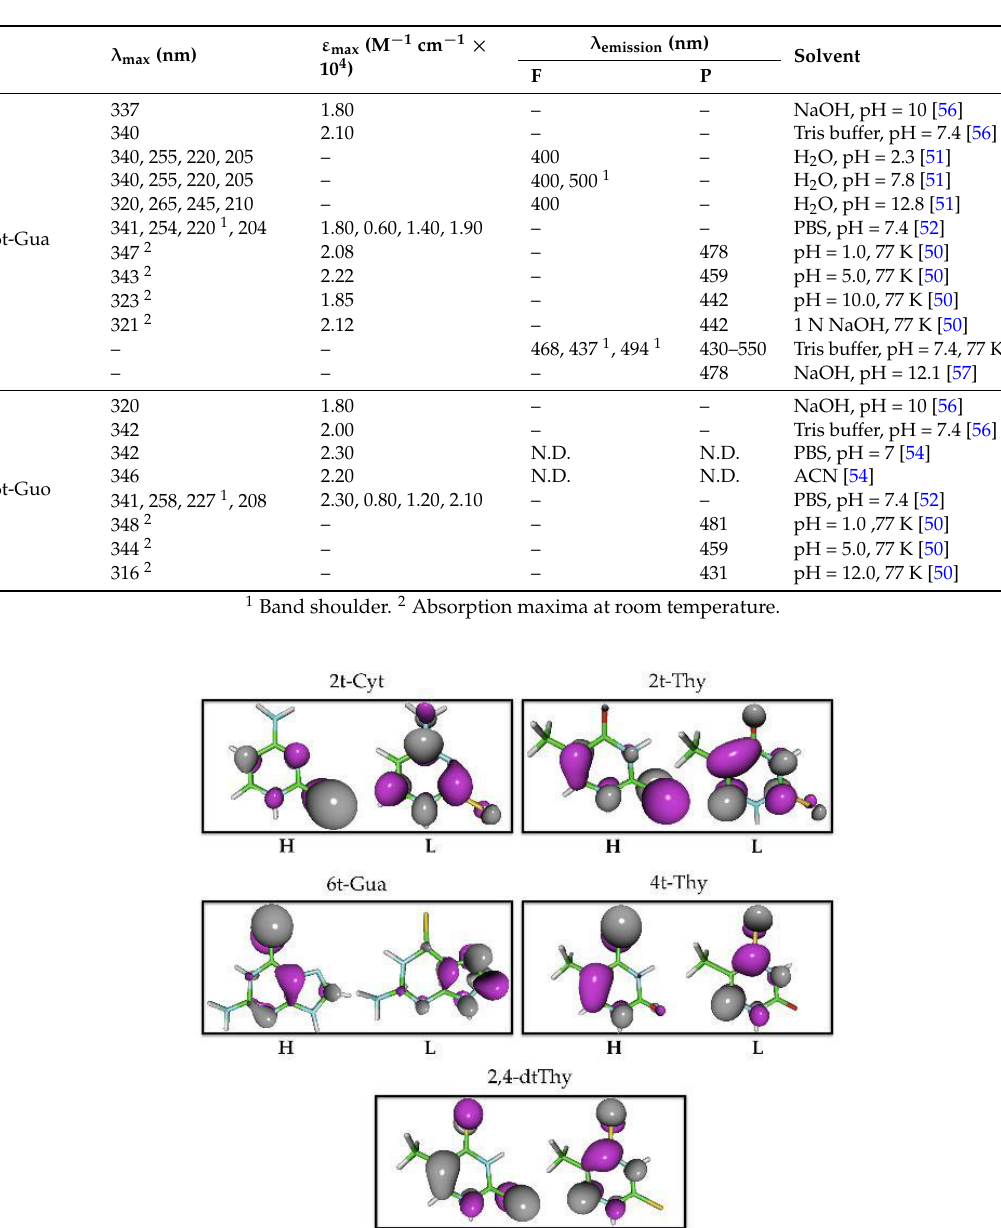
Table 1. Steady-state absorption and emission properties of 6-thioguanine nucleobase and nucleosides at room temperature unless otherwise indicated. F: Fluorescence; P: Phosphorescence; N.D.: Not detected.